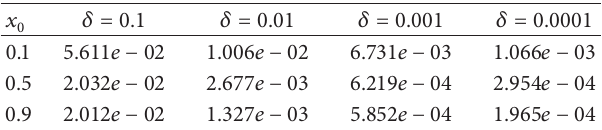
Table 5: The obtained values of RES (𝑓) using MFSRBF for various levels of noise 𝛿 , different values of 𝑥 0 , and 𝑇 = 4.1